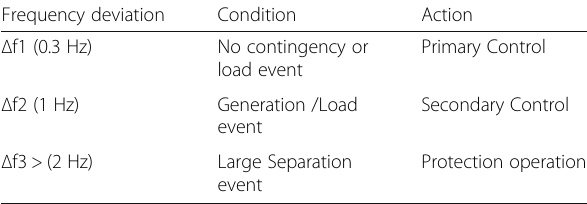
Table 2 Frequency and control/protection actions